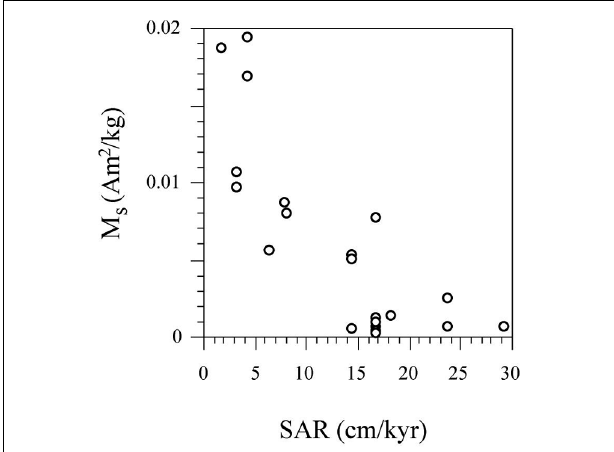
FIGURE 11 | Illustration of the inverse correlation between M s , which is taken as a proxy for the concentration of magnetofossils, and estimated